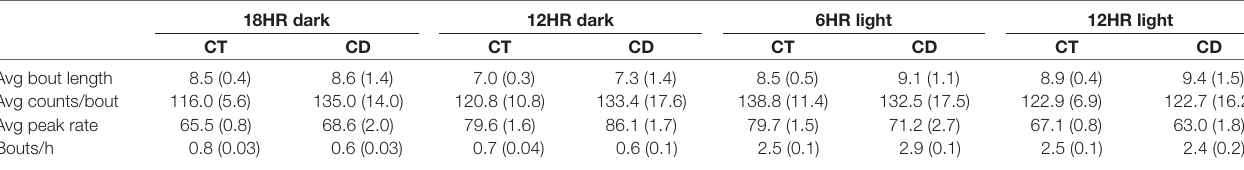
TABLE 5 | Bout analysis of alcohol drinking by photoperiod in the 6HR environmental